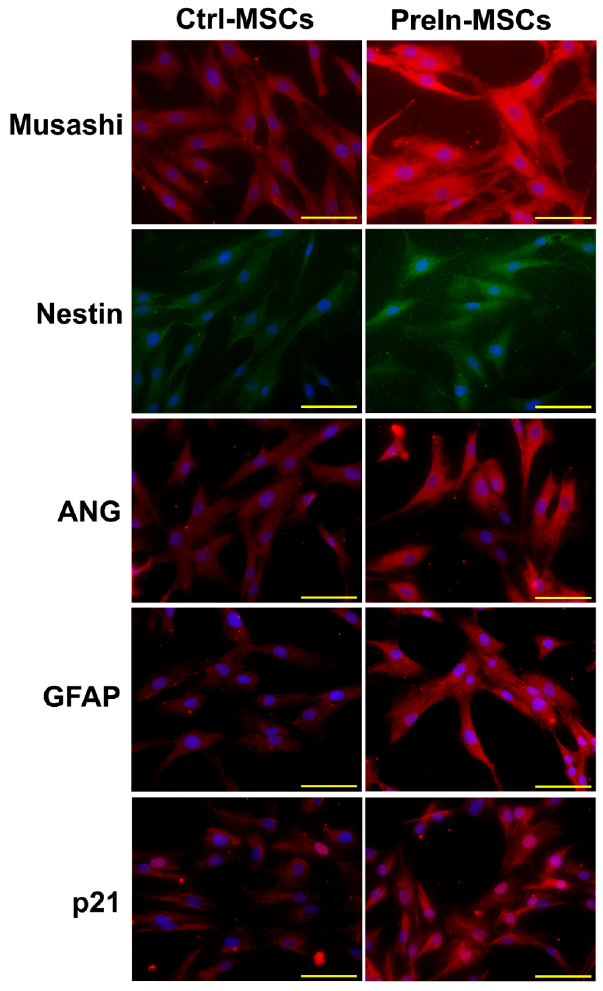
Figure 2. Control (Left panel) and pre-induced MSCs (Right panel) were fixed and stained with spe- cific antibodies, Muisashi, Nestin, ANG, GFAP, and p21, and visualized under fluorescent microscopy (red and green). Blue indicates nucleus. Pre-induced MSCs indicates preinduced-MSCs which are incubated with preinduction media for 24